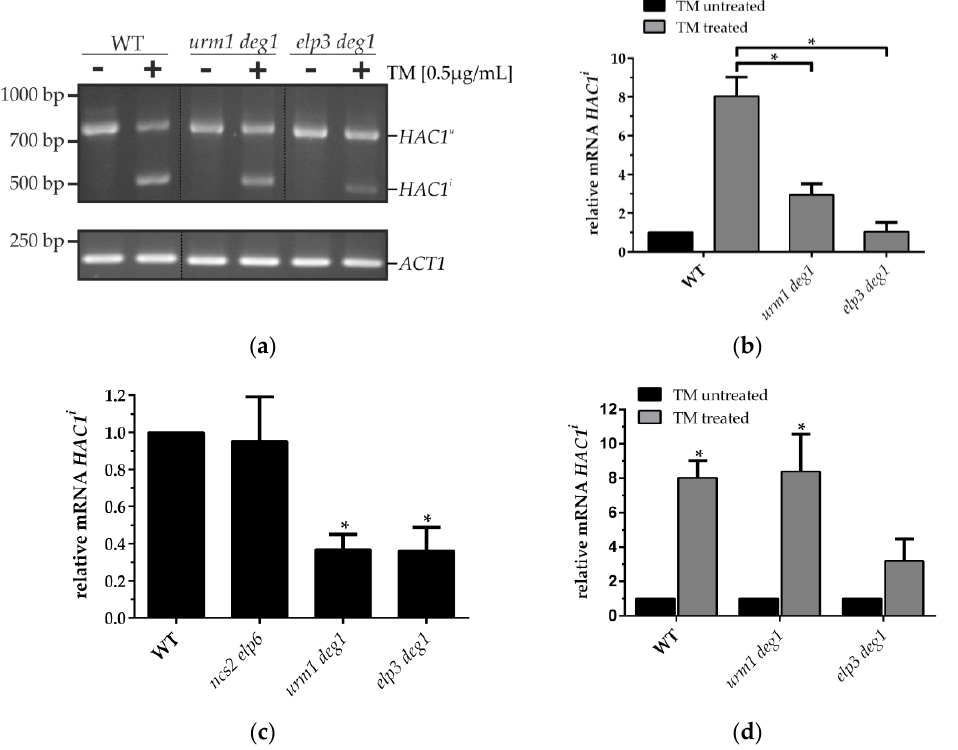
Figure 1. Analysis of basal and tunicamycin (TM) induced HAC1 splicing in various transfer RNA (tRNA) modification mutants. ( a ) To measure the splicing of HAC1 mRNA in wildtype (WT), elp3 deg1 and urm1 deg1 cells RT-PCR was conducted as described [34]. In each sample, ACT1 mRNA was detected as a control. Yeast strains were cultivated in yeast peptone dextrose (YPD) until OD 600 = 1.0 and harvested for RNA extraction. As a control, WT was additionally treated with TM (0.5 µg/mL) for 3 h (+). HAC1 u represents the unspliced HAC1 mRNA and HAC1 i the mature spliced HAC1 mRNA. ( b – d ) Quantification of the HAC1 i mRNA level without ( b ), and with TM treatment ( c , d ) via qRT-PCR of the indicated strains. Induction of HAC1 splicing with TM was carried out as described in ( a ). mRNA levels were normalized to ACT1 using the ΔΔCt method [33]. The results obtained with TM treated yeast strains were standardized against the HAC1 i mRNA level of the untreated wild-type ( c ) or the corresponding untreated strains ( d ), respectively. Quantitative PCR was performed with at least three biological triplicates per strain and condition and statistical significance was determined using a two-tailed t -test and indicated in the bar charts (* p < 0.05, b – d ).